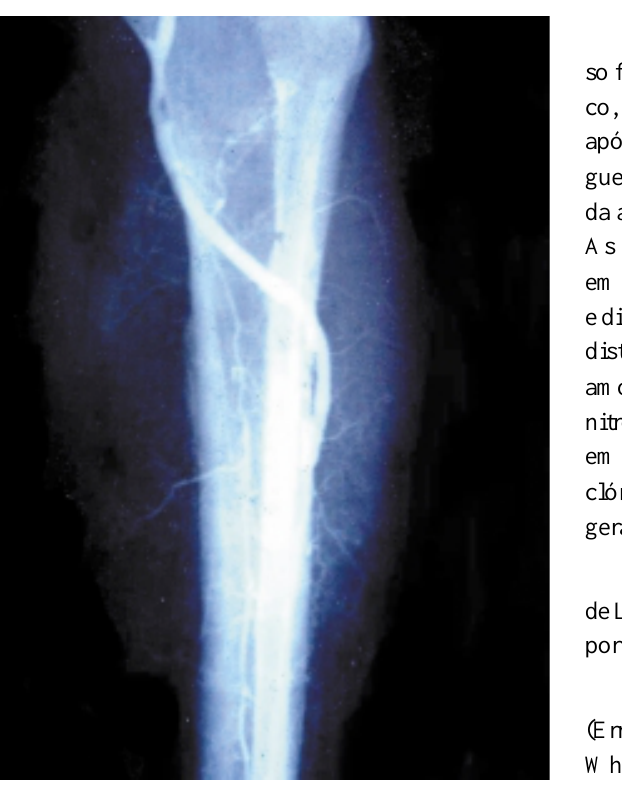
FIGURA 2 - Derivação femoro-tibial posterior.